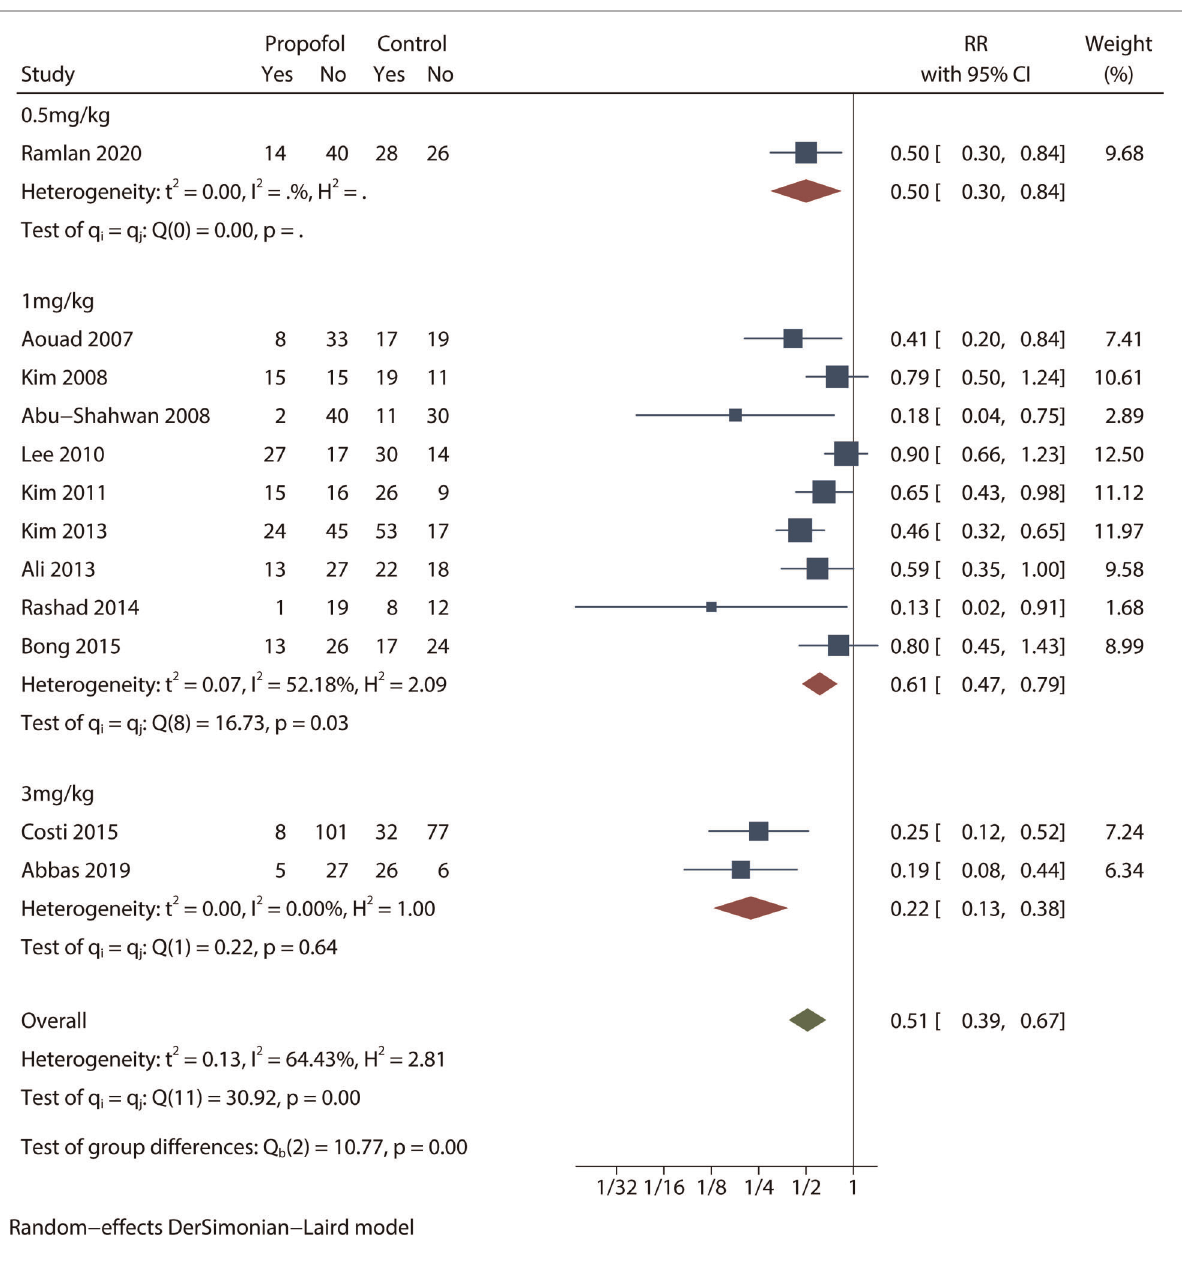
FIGURE 3 Subgroup analysis for EA incidence based on the dose of